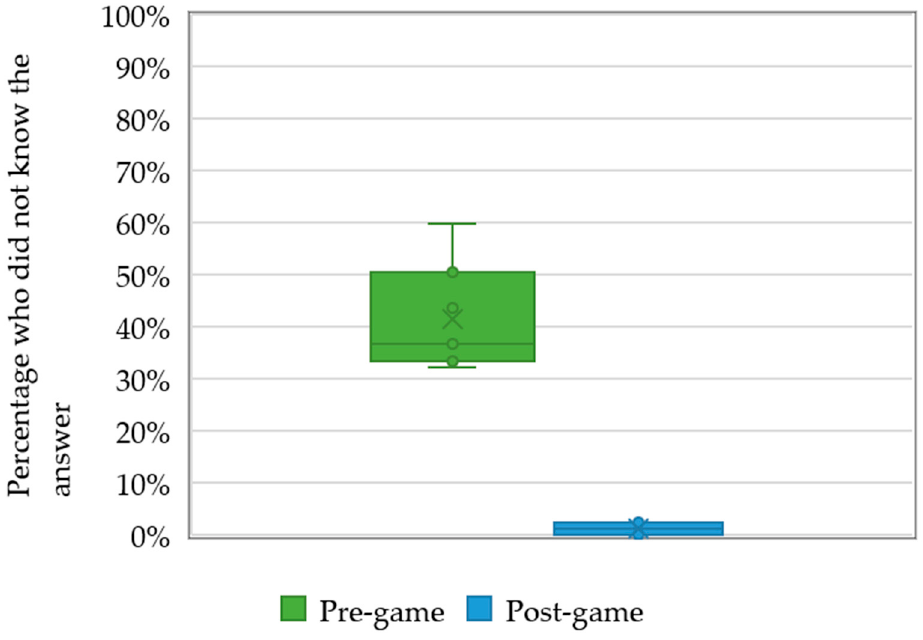
Figure 15. Percentage of students who did not know the answer pre- and post-game.